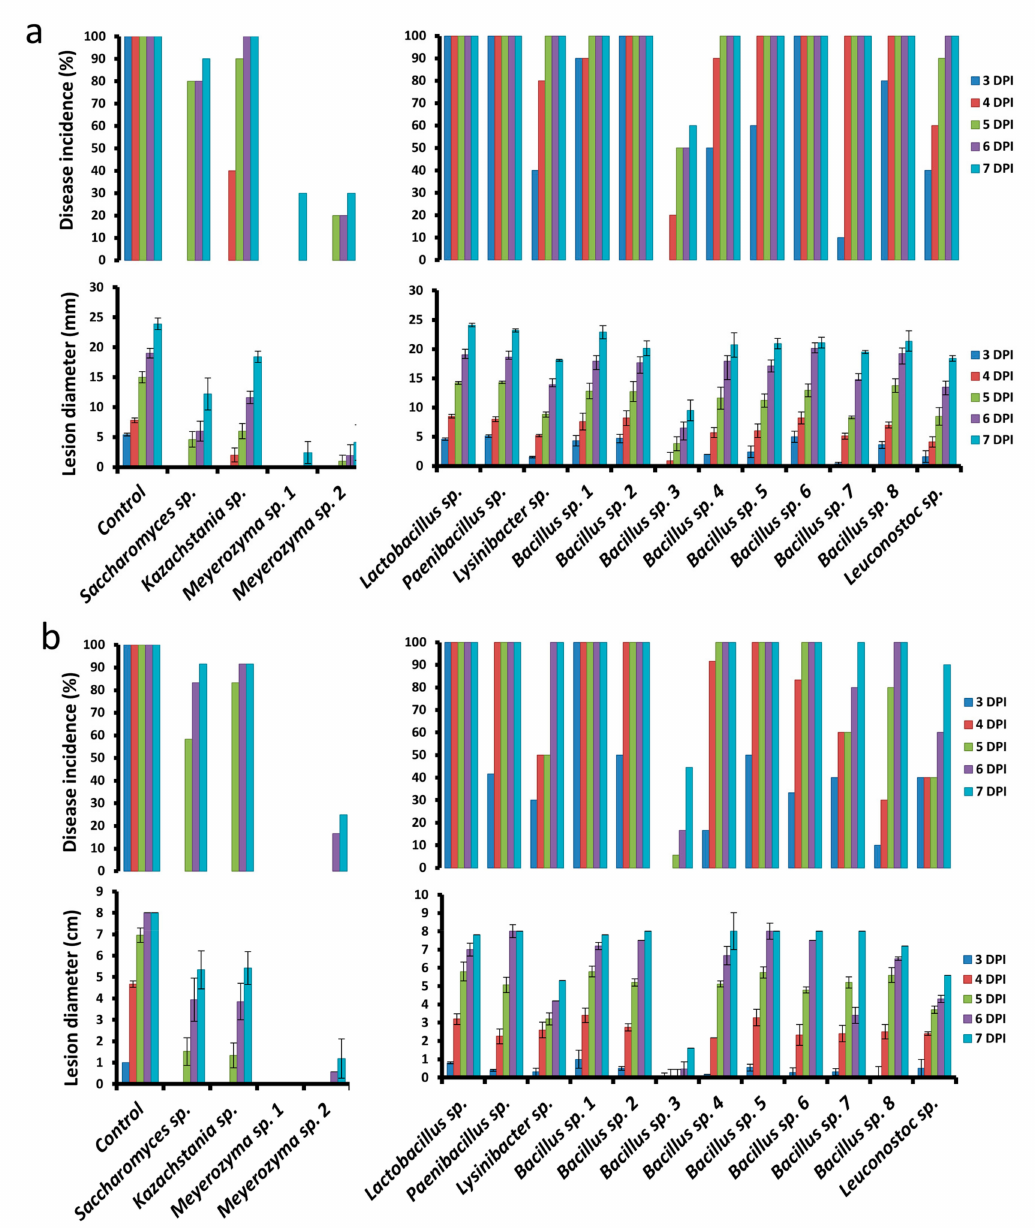
Figure 7. E ff ect of bacterial and yeast isolates from kefir grains on disease incidence (lesion diameters of the wounds) and severity (percent wounds infected) against Penicillium expansum on apple ( a ) and P. digitatum on grapefruit ( b ). Fruit were treated with suspensions of individual isolates (10 8 CFU mL − 1 ) and inoculated 2 h later with P. expansum or P. digitatum (10 5 spores ml − 1 ) or 30 µ L sterile distilled water in control and measurements were taken at 3, 4, 5, 6, and 7 days post-inoculation (DPI). Bars indicate standard errors of the